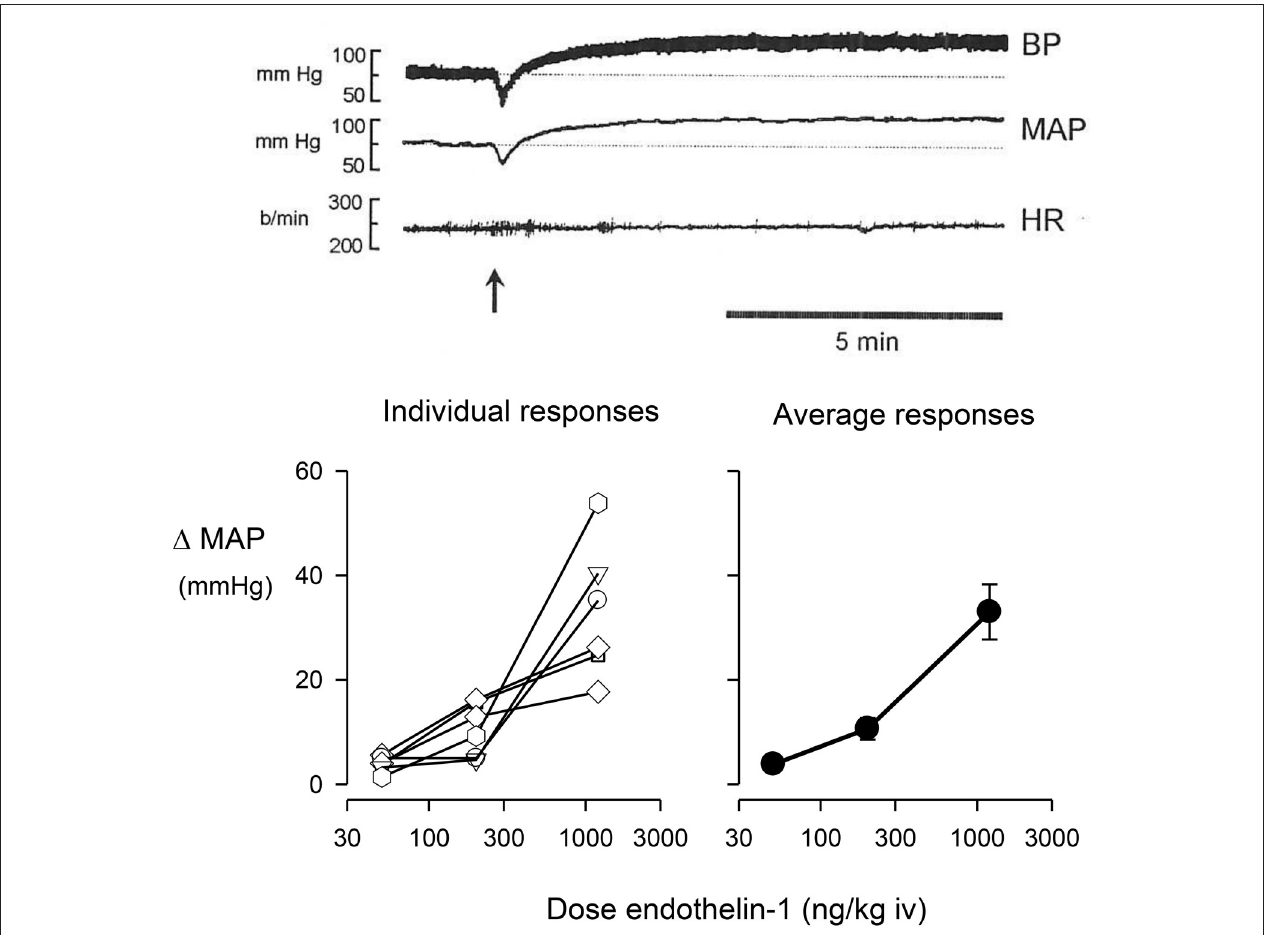
FIGURE 1 | Change in mean arterial pressure (MAP) induced by the intravenous (iv) injection of endothelin-1. The top panel shows a typical trace of pulsatile blood pressure, mean blood pressure, and heart rate of a conscious, ganglion blocked rabbit, before and after injection of 1200 ng/kg of endothelin-1 shown at arrow. The bottom left panel shows individual maximal pressor responses of six conscious rabbits to doses of 50, 200, or 1200 ng/kg of endothelin-1, while the bottom right panel shows the average responses of these